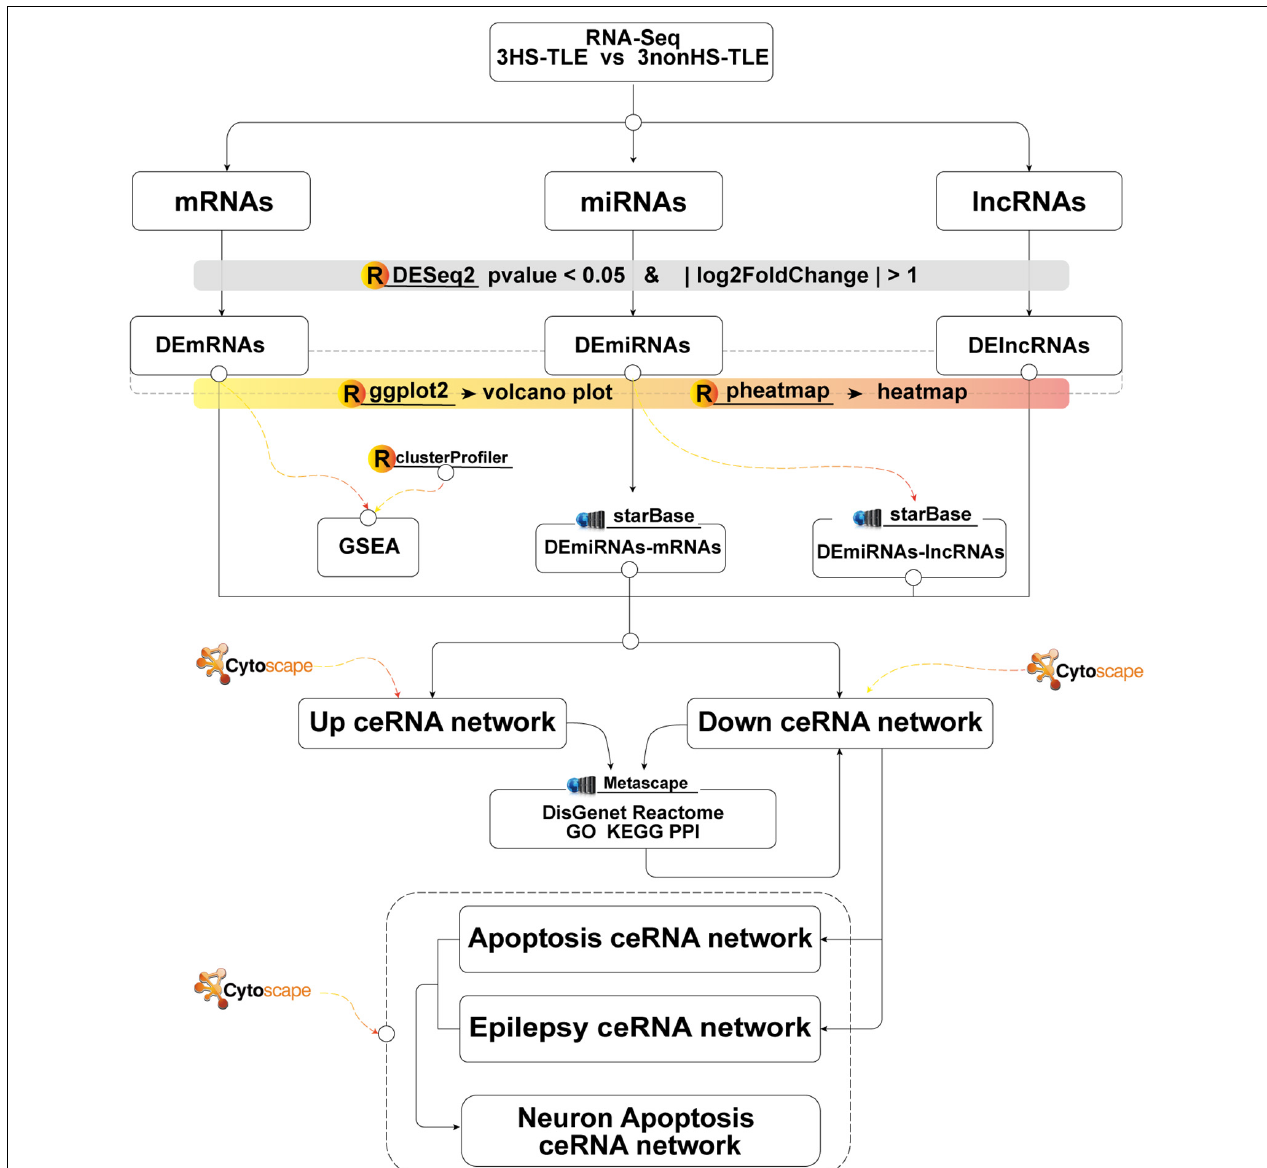
FIGURE 1 | Flow chart of constructing lncRNAs-miRNAs-mRNAs ceRNA